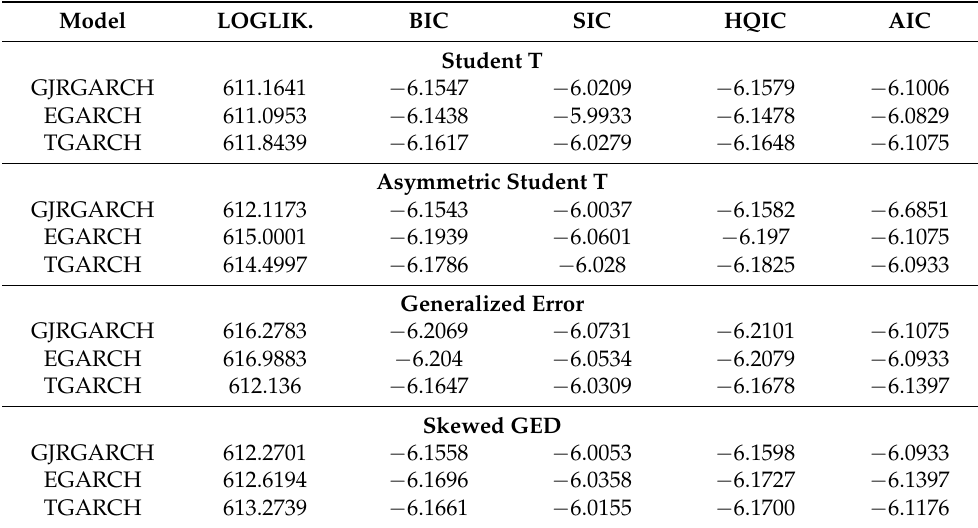
Table A2. GARCH model selection of PSX-100 closed returns before COVID-19